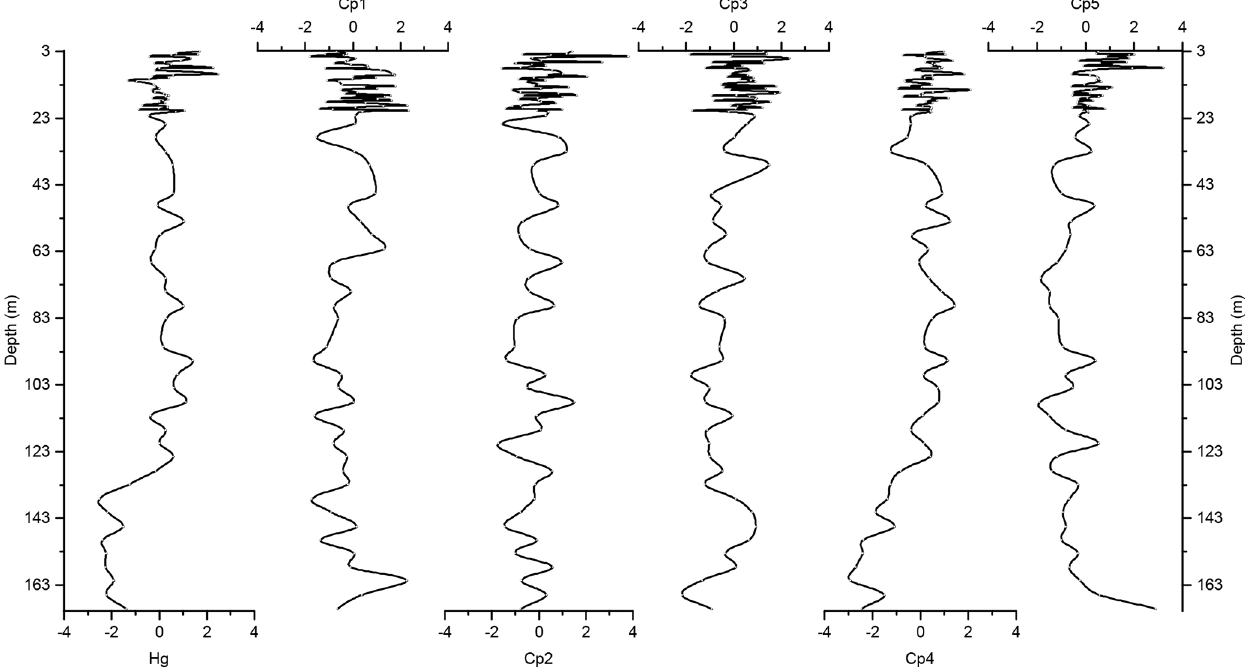
Figure 6. Depth records of scores of the principal components extracted by PCA on the elemental composition of the sediments along with Z score of Hg of the Adélie Basin sediments.